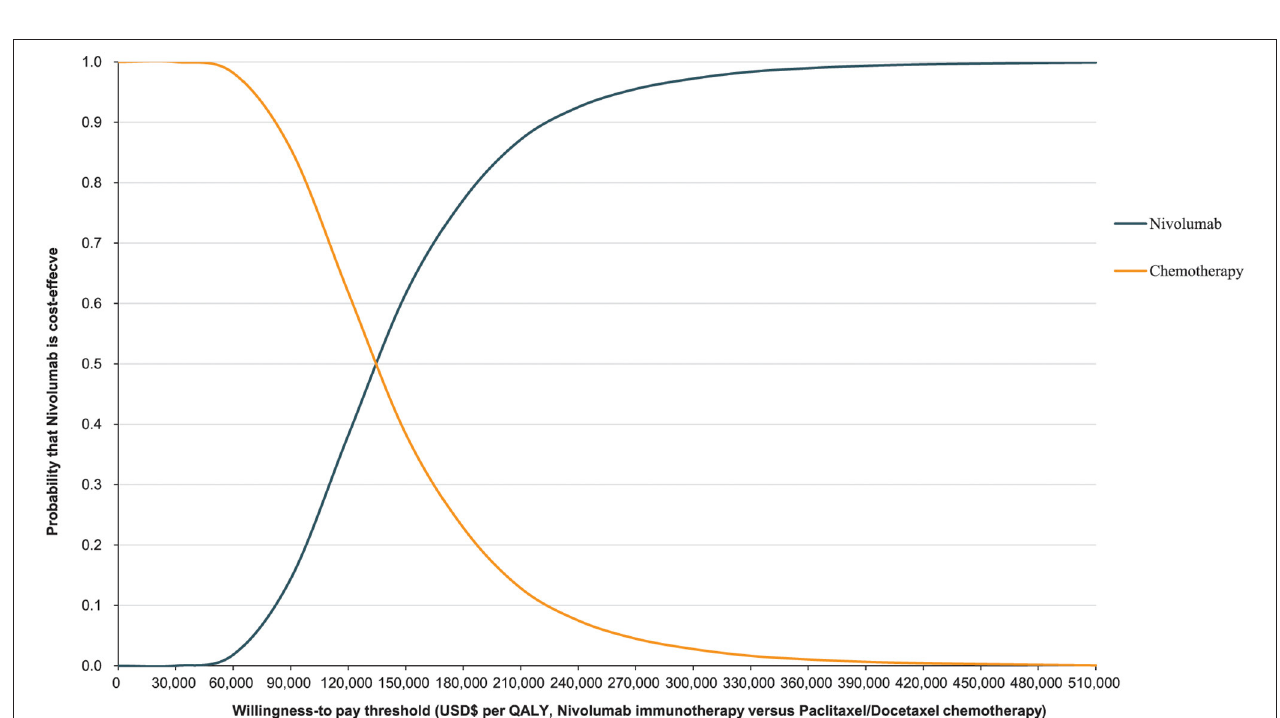
FIGURE 6 | Cost-effectiveness acceptability curve for nivolumab immunotherapy vs. paclitaxel or docetaxel chemotherapy.